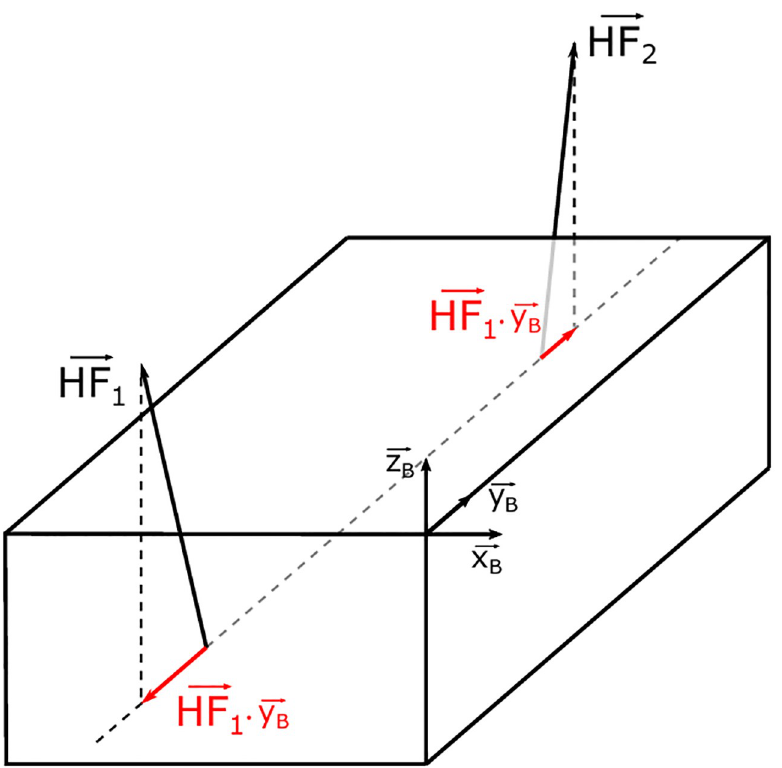
Fig 4. HF applied by both team members and their respective projections on the longitudinal axis of the box ~ y